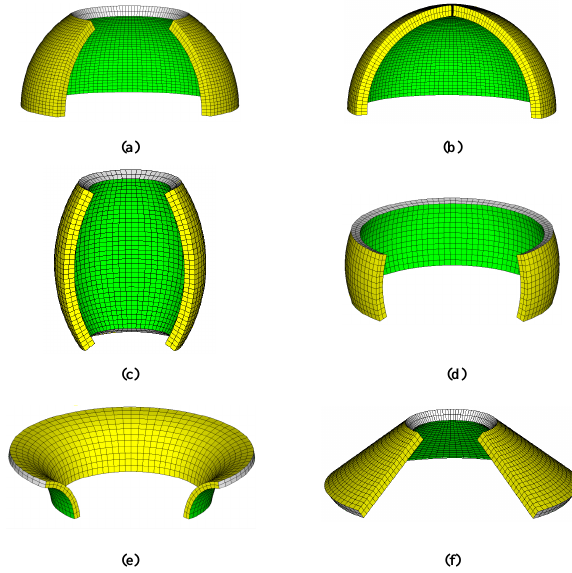
Figure 2: FGM panels structures: (a) spherical panel; (b) spherical cap; (c) Toro-circular panel ( R b < 0); (d) Toro-circular panel ( R b > 0); (e) Toro-parabolic panel; (f) Parabolic